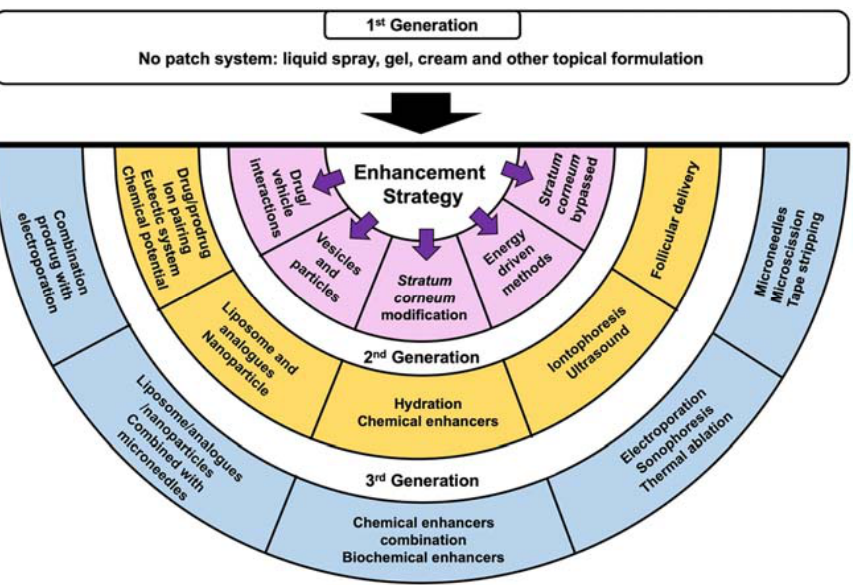
Figure 1. Schematic view of skin permeation pathways: intercellular, transcellular, and transap-